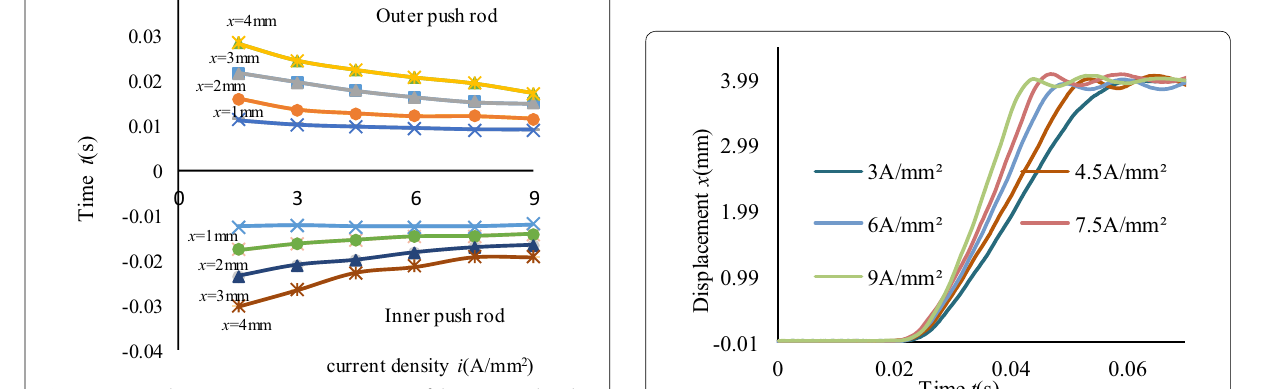
Figure 21 Displacement response time curve of the outer rod and inter rod